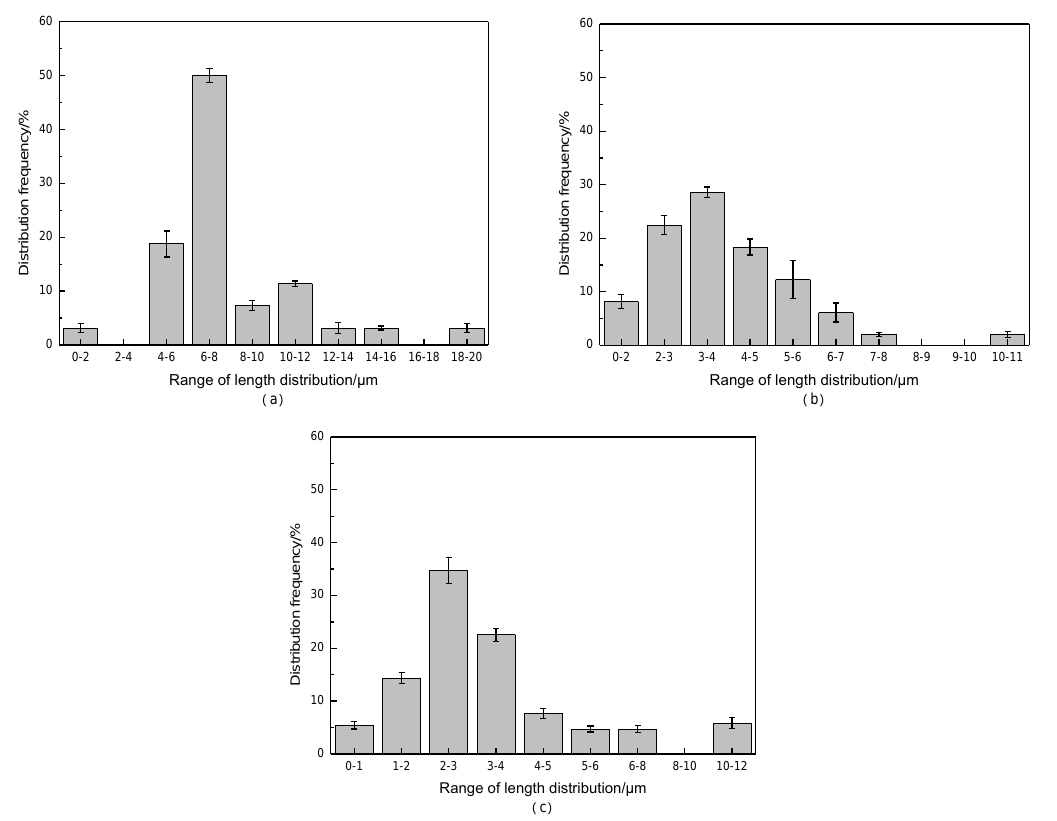
Figure 8. Quantitative analysis of cement hydration products distribution. ( a ) G1 mixture. ( b ) G3 mixture. ( c ) G3-2 mixture.